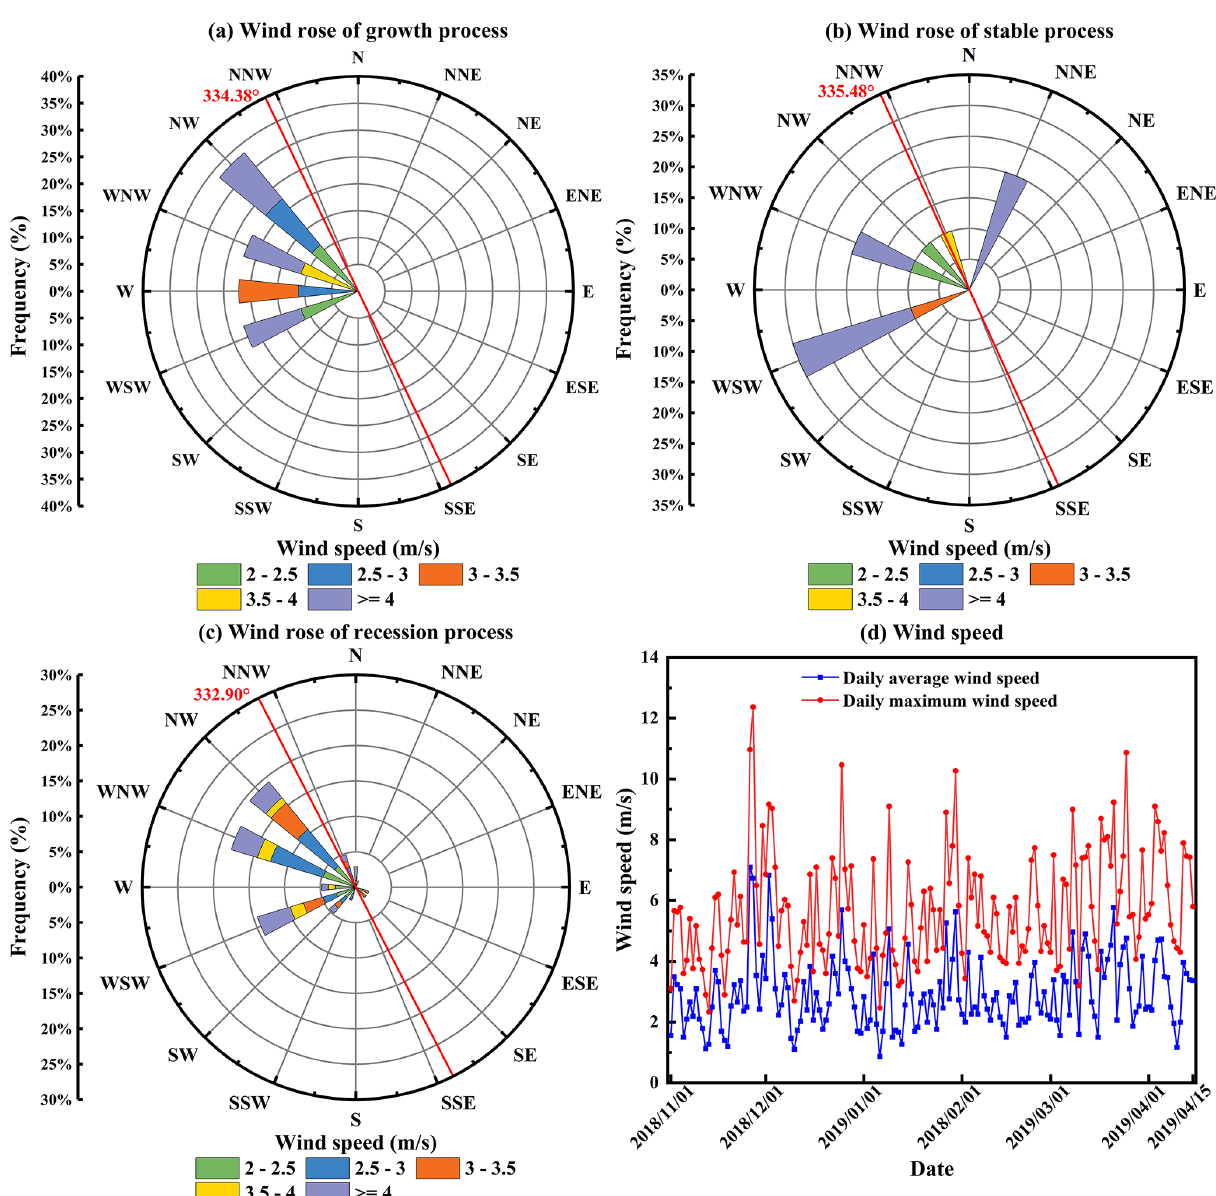
Figure 8. The wind field of Chagan Lake during the cold season of 2018. (a) Growth process from 22 to 30 November 2018. (b) Stable pro- cess. (c) Recession process from 15 to 24 March 2019. (d) Daily average and maximum wind speed from 1 November 2018 to 15 April